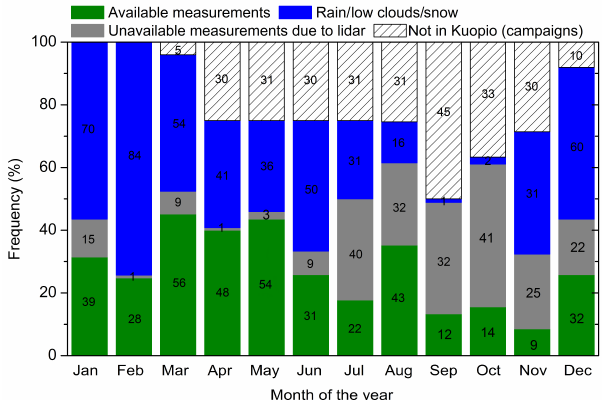
Figure 4. Monthly percentages of nighttime profiles for the pe- riod between 15 November 2012 and 31 August 2016. The mea- surements have been categorized depending on their availability as: available, unavailable measurements due to lidar, not in Kuo- pio (campaigns) and unavailable due to rain/low clouds/snow. The numbers on top of the color bars indicate the number of profiles for each category.